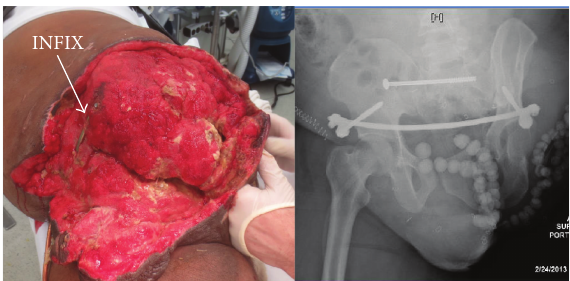
Figure 1: (Case 1) 41yo male crushed by fork lift. APC 3 massive open pelvic ring injury and mangled left lower extremity arrived in extremis. The left leg with a vascular injury was debrided, had an above knee amputation, and eventually resulted in a hip disarticulation.